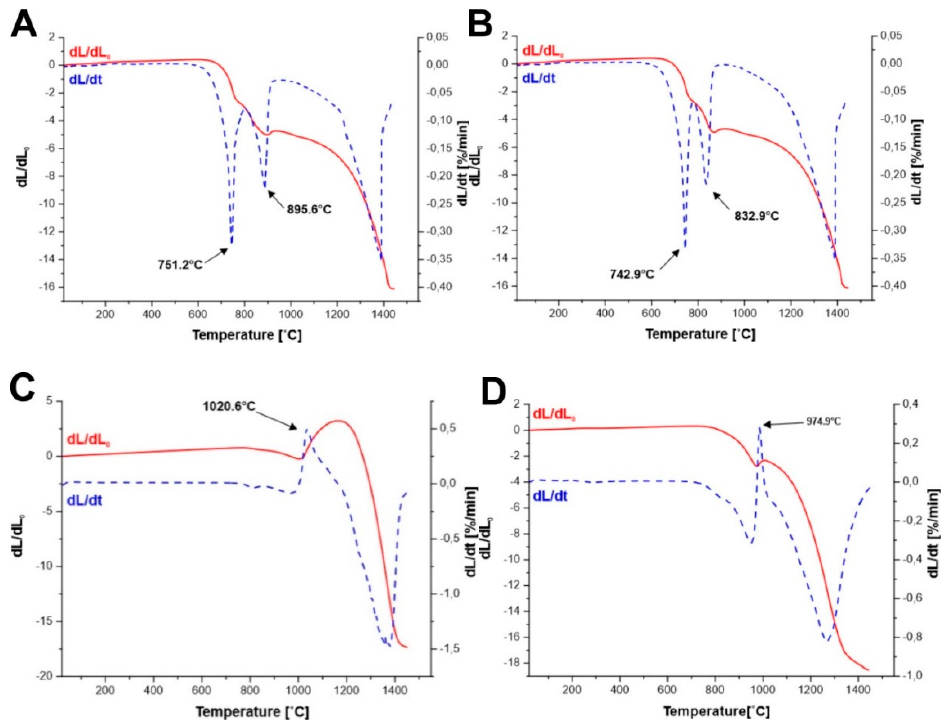
Figure 3. Dilatometric and derivative curves of precursor powders: ( A )—Method A; ( B )—Method B; ( C )—Method C; ( D )—Method